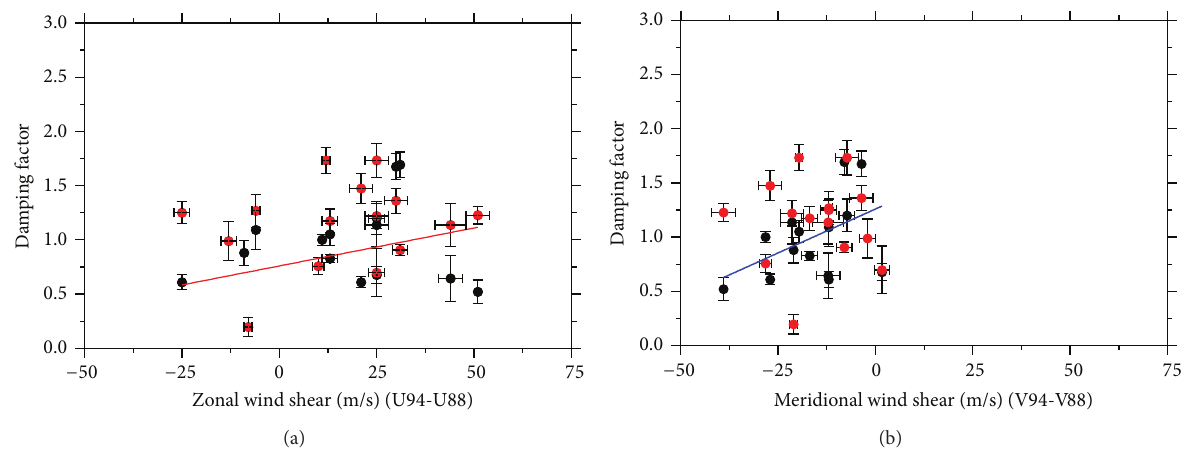
Figure 7: The distribution of damping factors with respect to the observed zonal (a) and meridional (b) wind shears between 87 and 94 km altitudes. Filled black and red circles show the results for principal and residual waves,